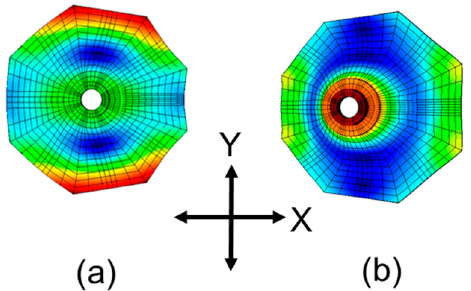
Figure 8. In-plane first and second mode shapes when only the bottom surface electrodes are electrically excited. Deformations are in the x -axis direction. ( a ) First in-plane mode at 68 kHz, ( b ) Second in-plane mode at 154.5 kHz.